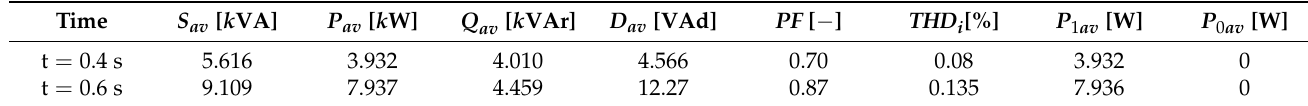
Table 7. Simulation results before and after the change (at steady states).